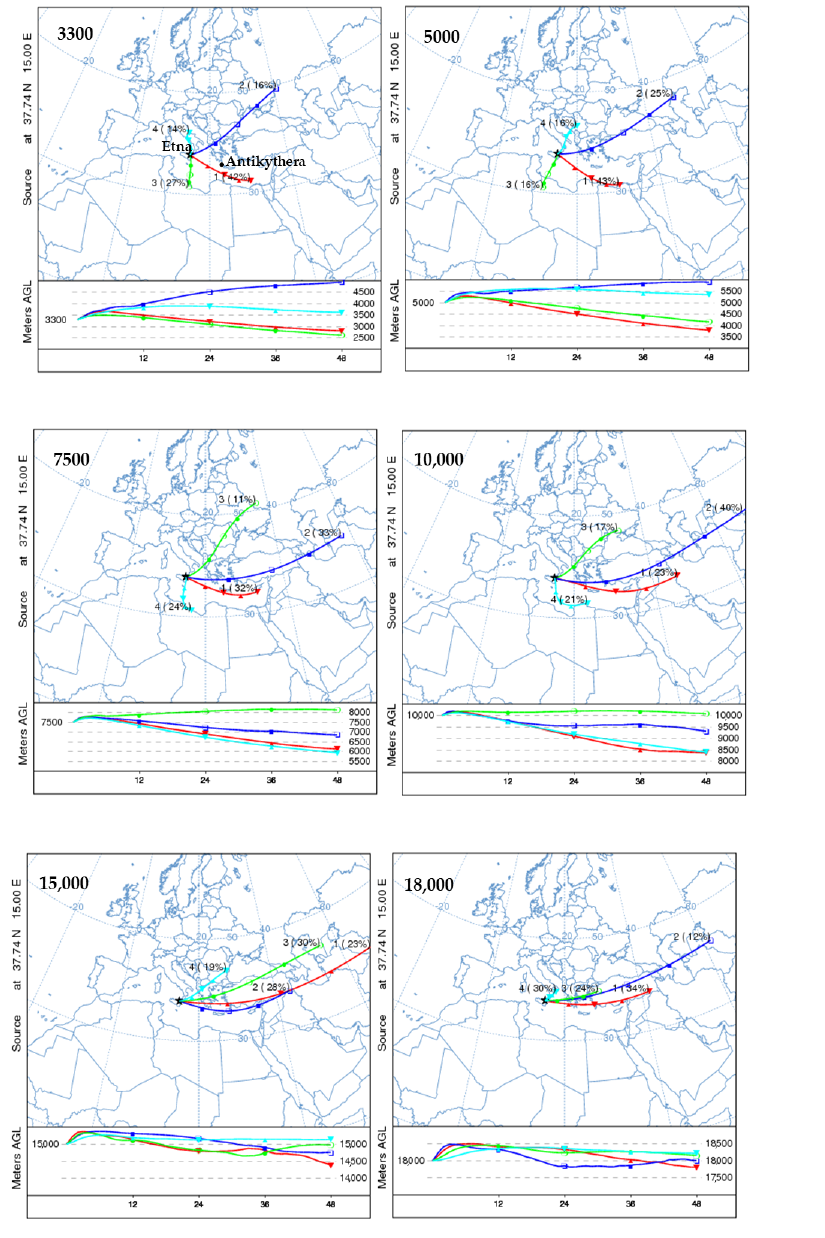
Figure 2. Cluster analysis of HYSPLIT forward trajectories (1816 in total) applied on 48 h forward trajectories of air masses from the Etna Volcano (37.74 ◦ N, 15.00 ◦ E), at 3300, 5000, 7500, 10,000, 15,000, and 18,000 m above ground level, using GDAS meteorological data, for a 5 years period (2015–2019). The main four air mass transport paths (centroids) are represented with colored lines (1–4 number are clusters of the mean trajectories), indicating the central path of air masses with similar characteristics and directions (see the percentages), as determined from the HYSPLIT cluster